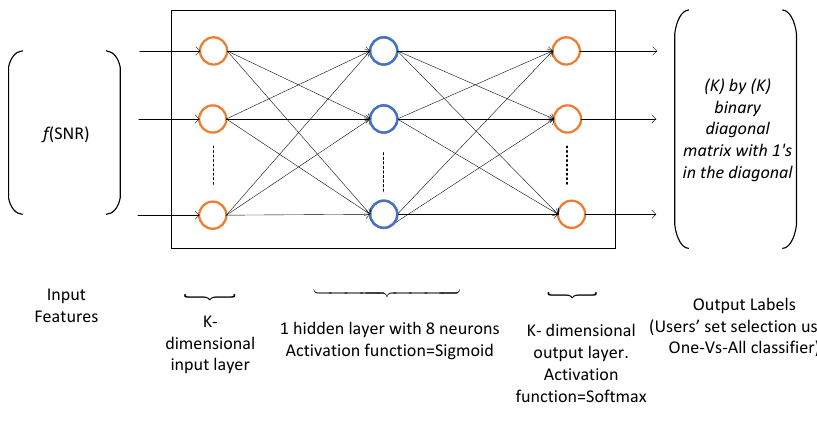
Figure 10. Neural network architecture for RB allocation, K =